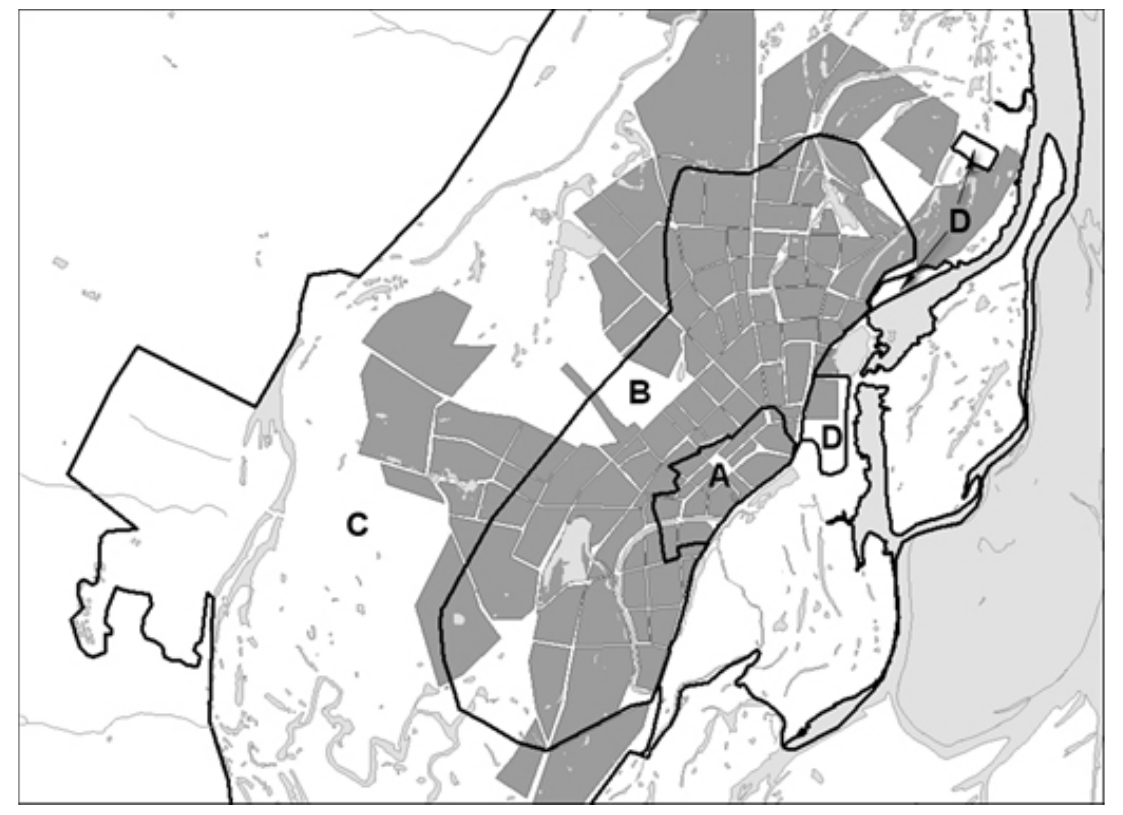
Figure 6. Zonation of Yakutsk by development age: A—old (>160 years); B—middle (70–160 years); C—young (<70 years); D—recent development on reclaimed floodplain (<40 years).